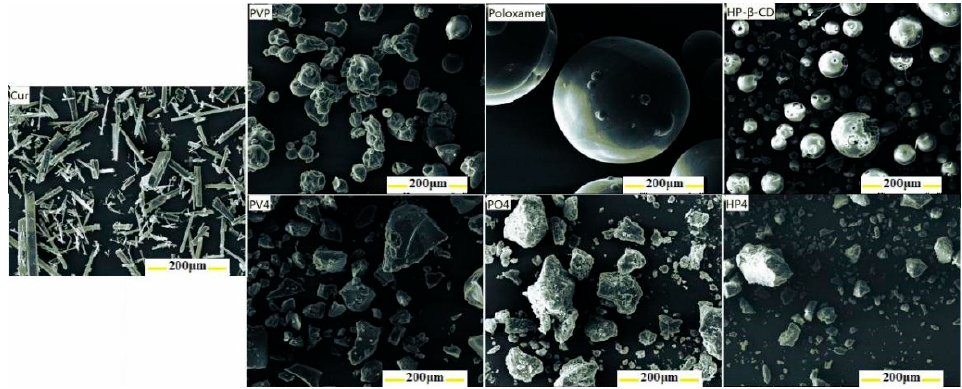
Figure 5. SEM images of the pure Curcumin, surfactant, and Curcumin solid dispersion.